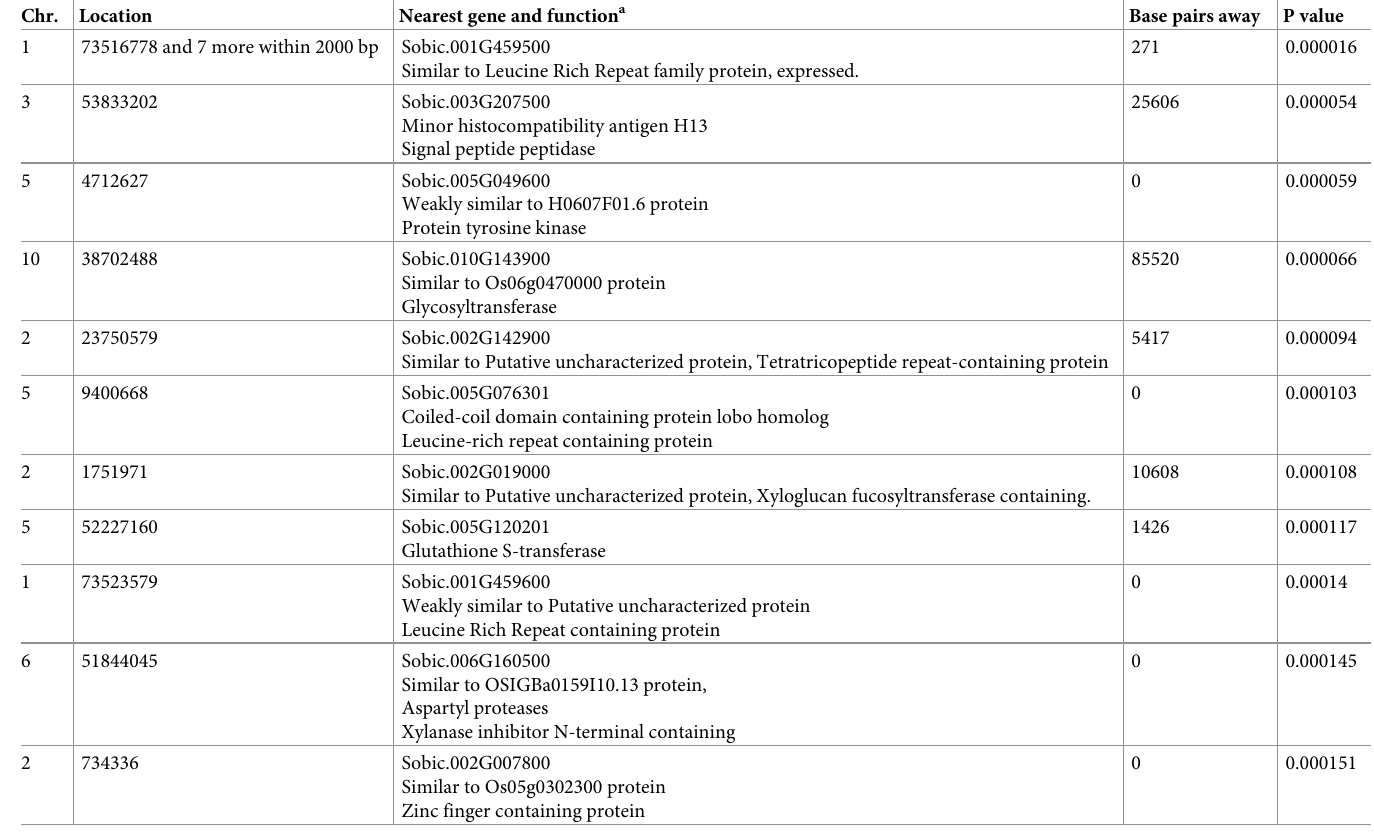
Table 3. Top SNPs associated with head smut. Chr.